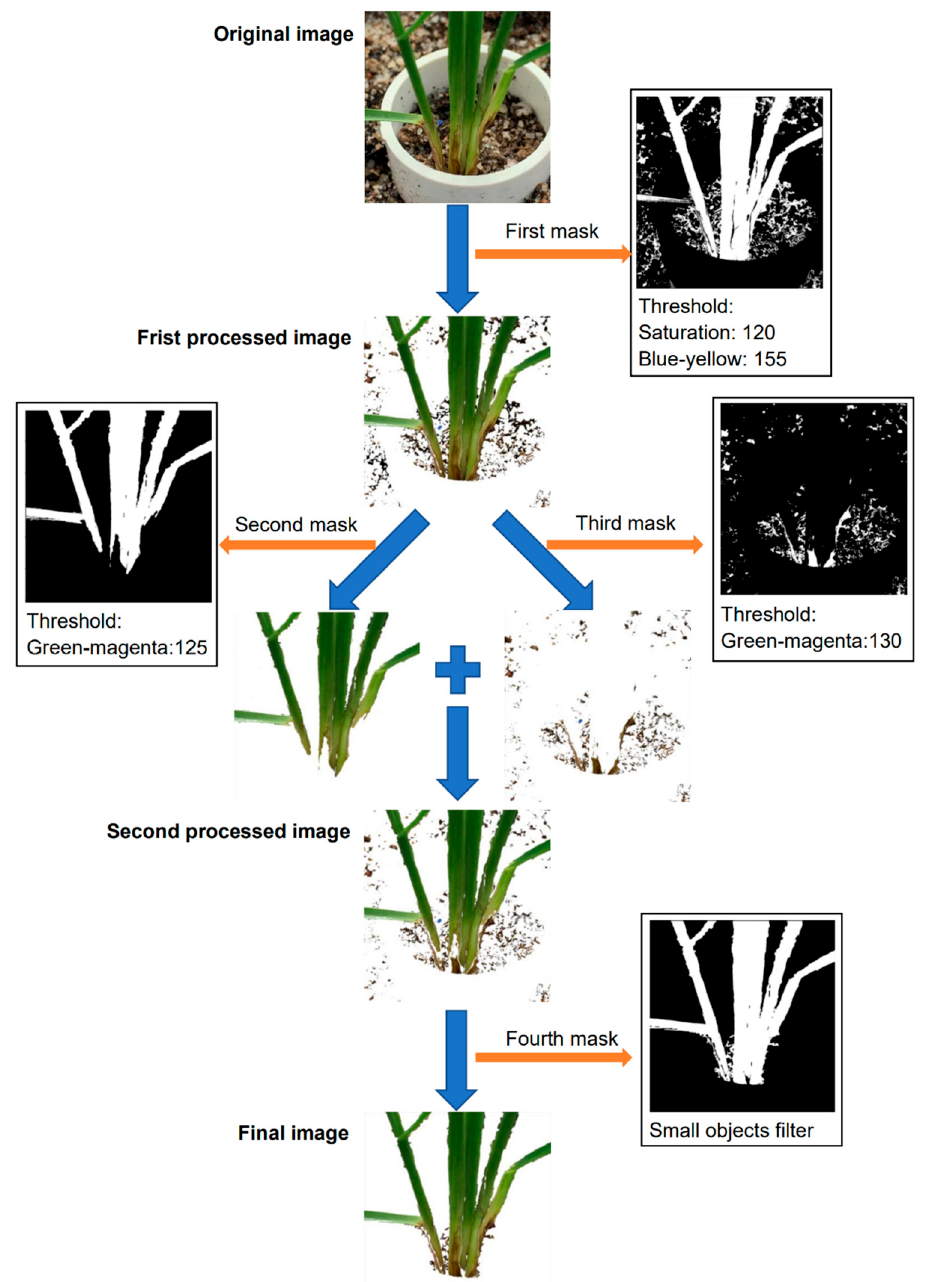
Figure 1. Workflow for image segmentation process. Image segmentation occurred by applying four different masks in sequence to the original image to extract the ROI and produce the final